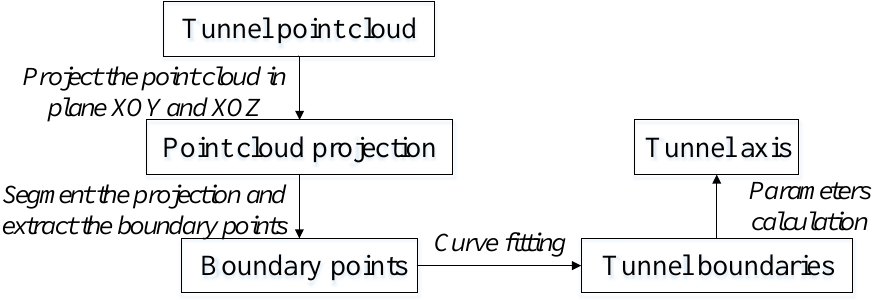
Figure 2. Flow chart of the acquisition of the circular tunnel